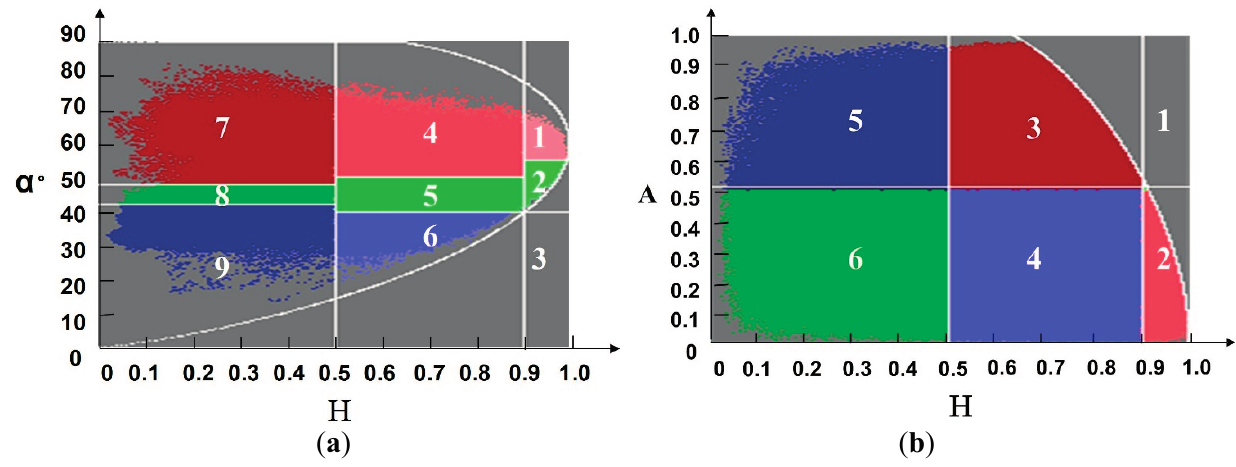
Figure 5. 2-D segmented planes: ( a ) H- α segmented plane and ( b ) H/A segmented